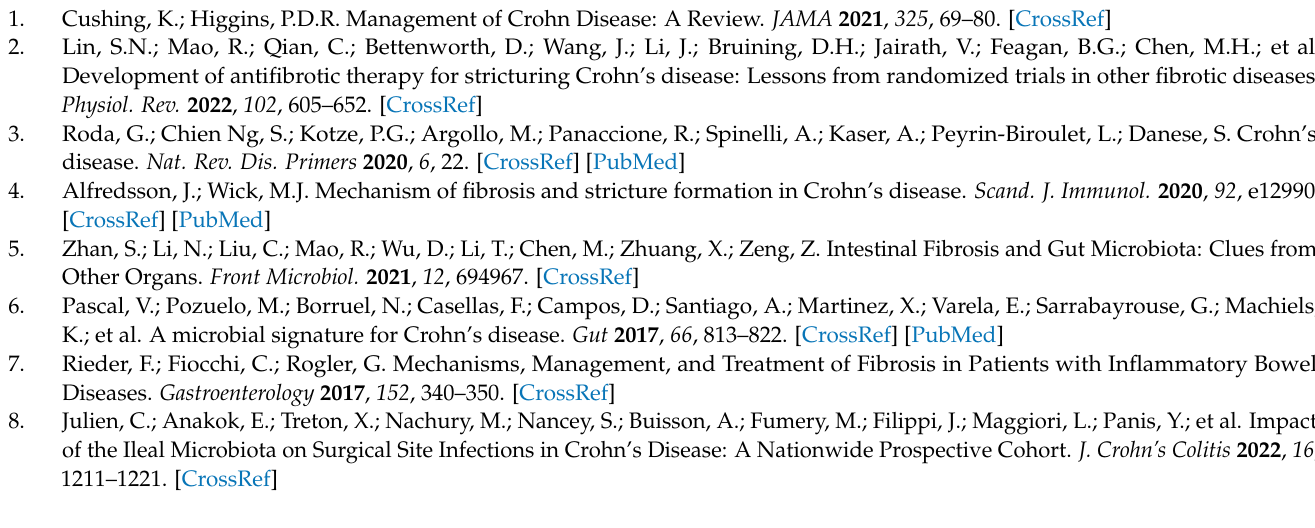
Table S1: Results of Spearman Rank Correlation between bacterial abundance difference (abundance in stenotic site—abundance in non-stenotic site) and